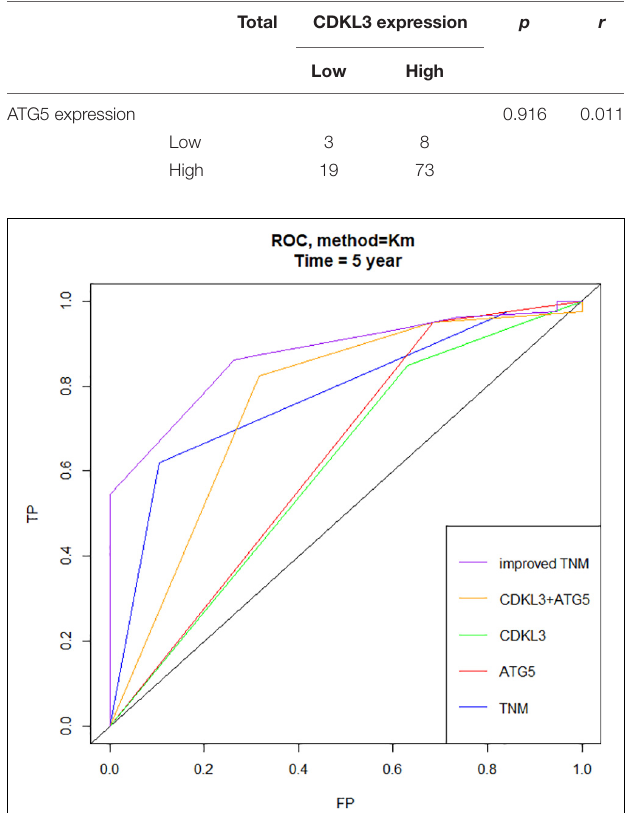
TABLE 4 | Association of CDKL3 expression levels with ATG5 expression status.